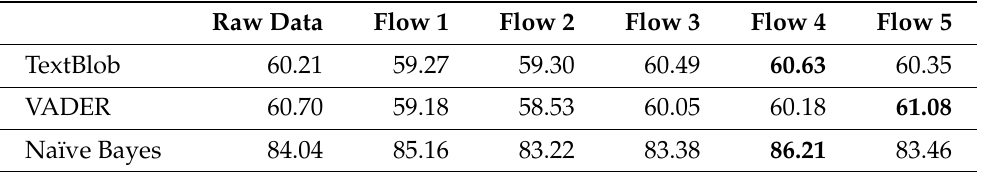
Table 3. Accuracy of the classifiers on the entire dataset.